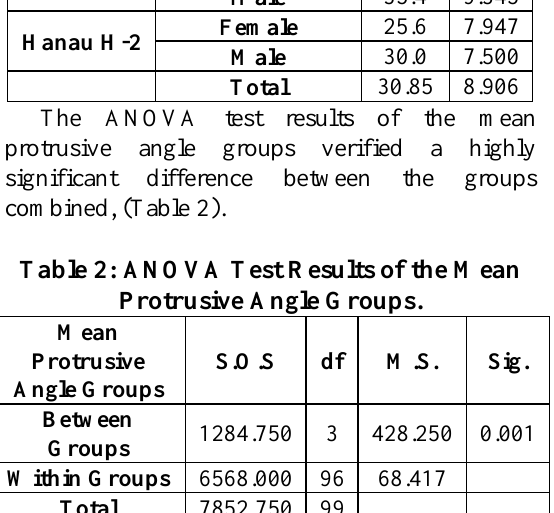
Figure 6: The condyle pin